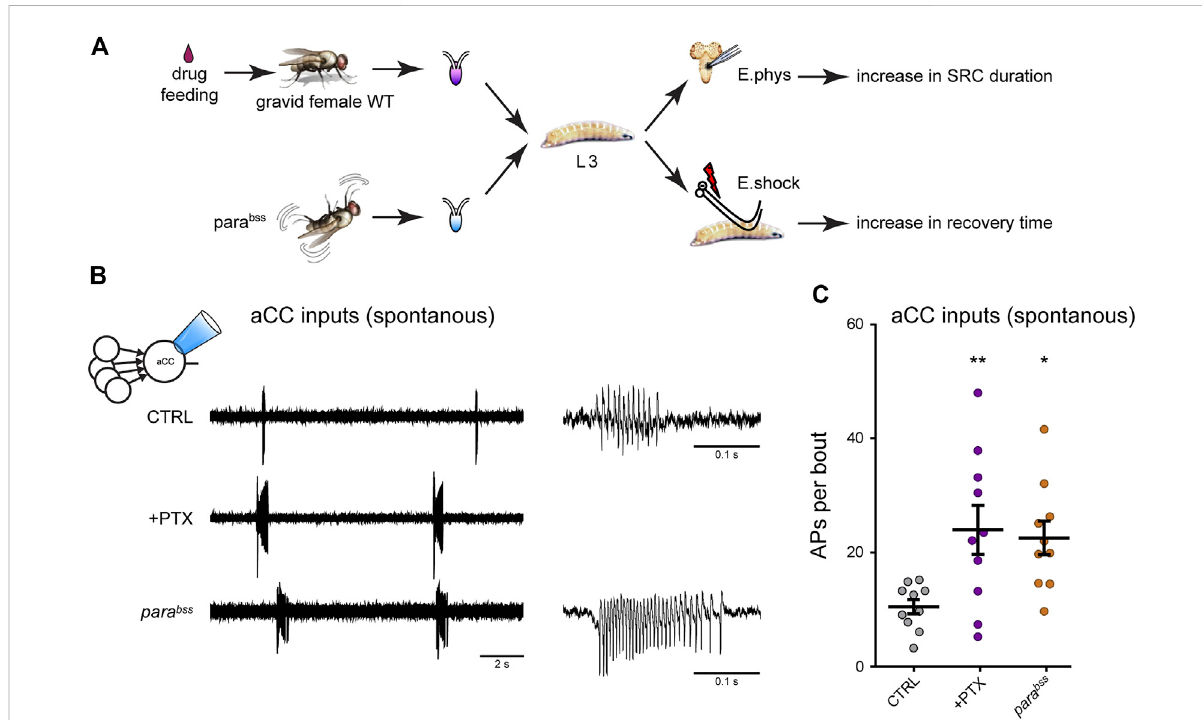
Manipulation of activity during the Drosophila locomotor CP results in a change to the excitation:inhibition balance (A) Exposure of gravid females to the proconvulsant compound PTX is suf fi cient to increase activity during the embryonic CP. The same is also achieved with the seizure- prone para bss mutant(MarleyandBaines,2011).Fivedayslater,wall-climbingL3larvaeweretestedbyeitherelectrophysiologicalrecordingfromaCC motoneurons orbyelectroshock(E.shock), inorder tomeasurechangeto synapticdrive (SRC, spontaneousrhythmiccurrent),orsusceptibility to induced seizure, respectively. (B) Recordings from L3-larval aCC motoneurons ( via the loose-patch technique) show increased endogenous (i.e., spontaneous) spiking activity in conditions of excessive CP excitation (PTX and para bss ). The spontaneous activity is driven by the endogenous central locomotor CPG. (C) Quanti fi cation of the number of action potentials per bout. One-way ANOVA (F (2,27) = 3.91, p = 0.03) followed